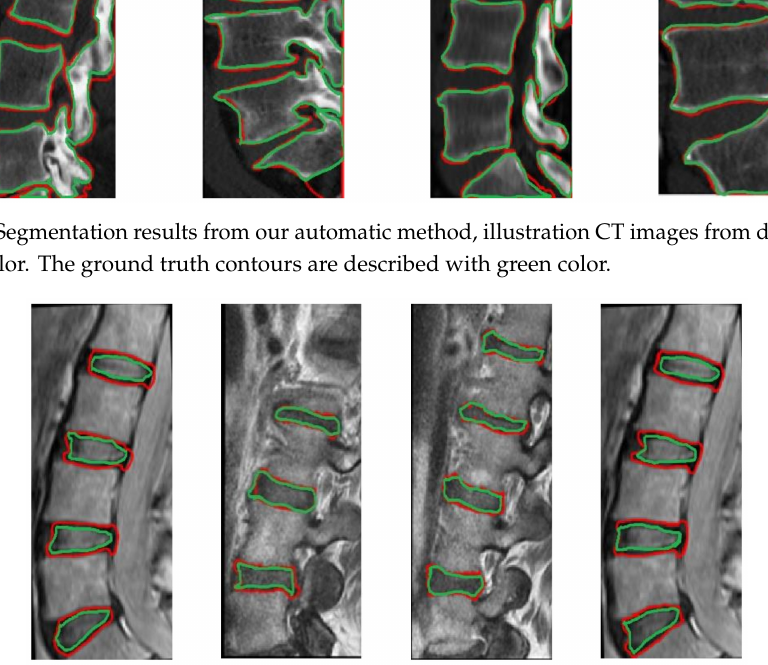
Figure 12. Segmentation results from our method, illustration MRI images from di ff erent data sets with red color. The ground truth contours are described with green